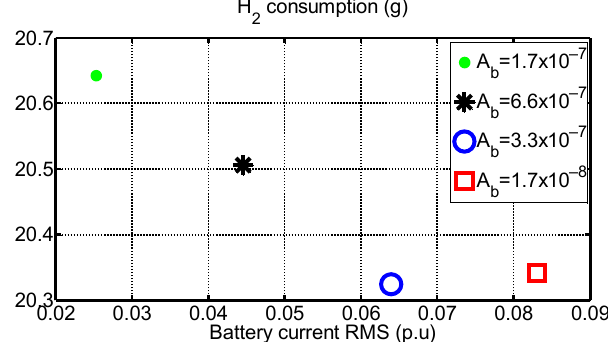
Figure 10. Corresponding Pareto optimal front to define the weighting factor A b.